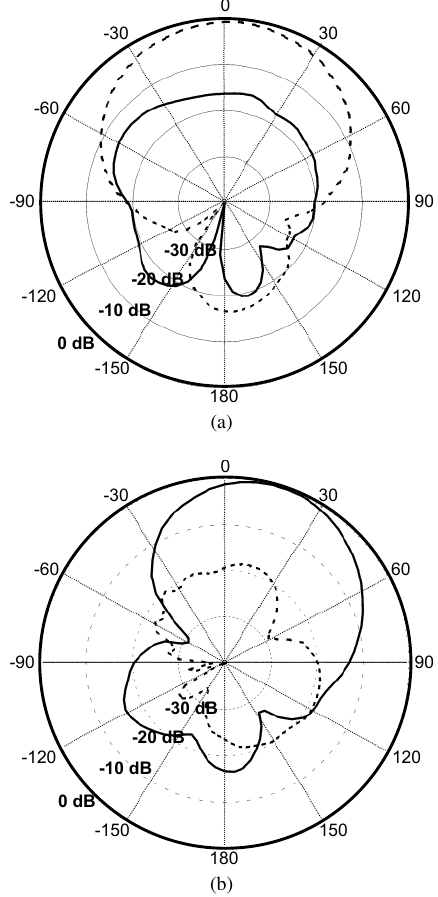
FIGURE 13. Measured radiation patterns of the half E-shaped patch at 2.5 GHz. — E θ , - - - E ϕ . (a) x - z plane. (b) y - z plane. Adapted from [22], where we have flipped the patterns according to the coordinate system in Fig.